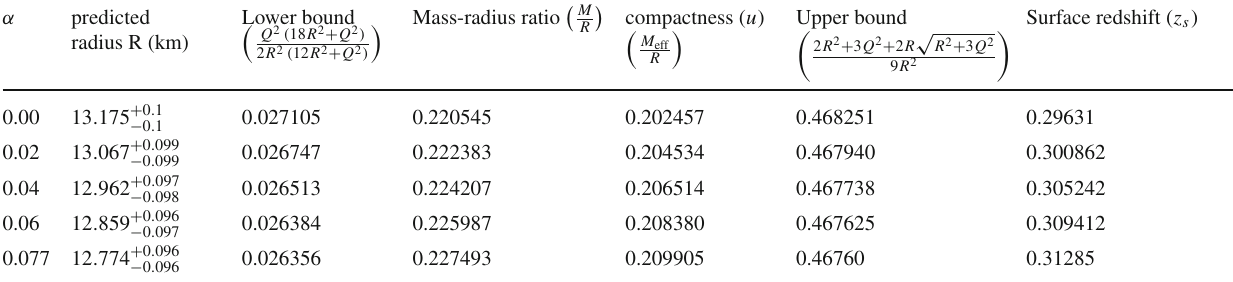
Table 3 Comparative study of lower bound, mass-radius ratio, upper bound, compactness ( u = M eff / R ) and surface red-shift of the star